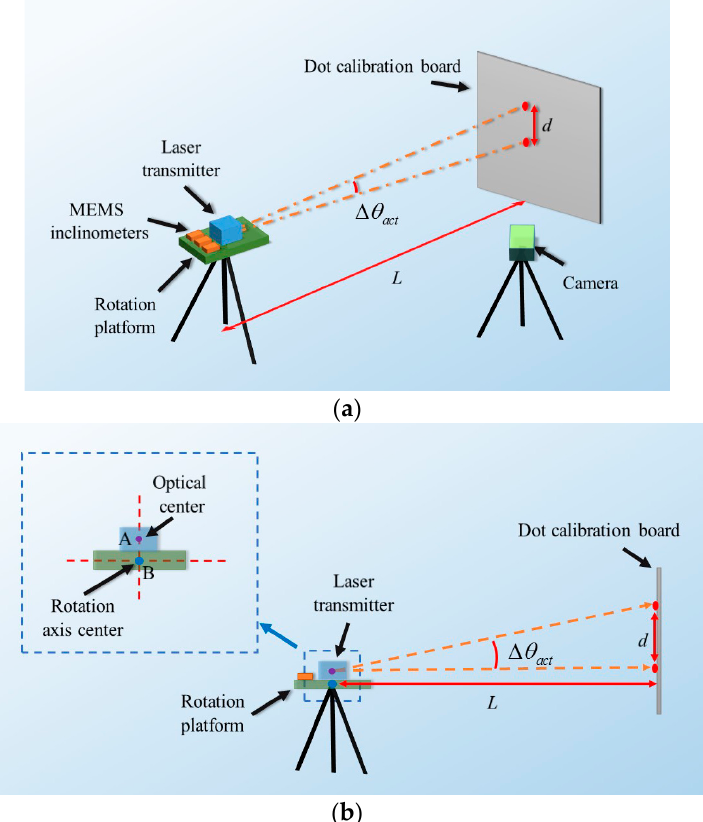
Figure 3. The proposed method for obtaining the key parameter. ( a ) Illustration of the method; ( b ) illustration of parameters of the method.